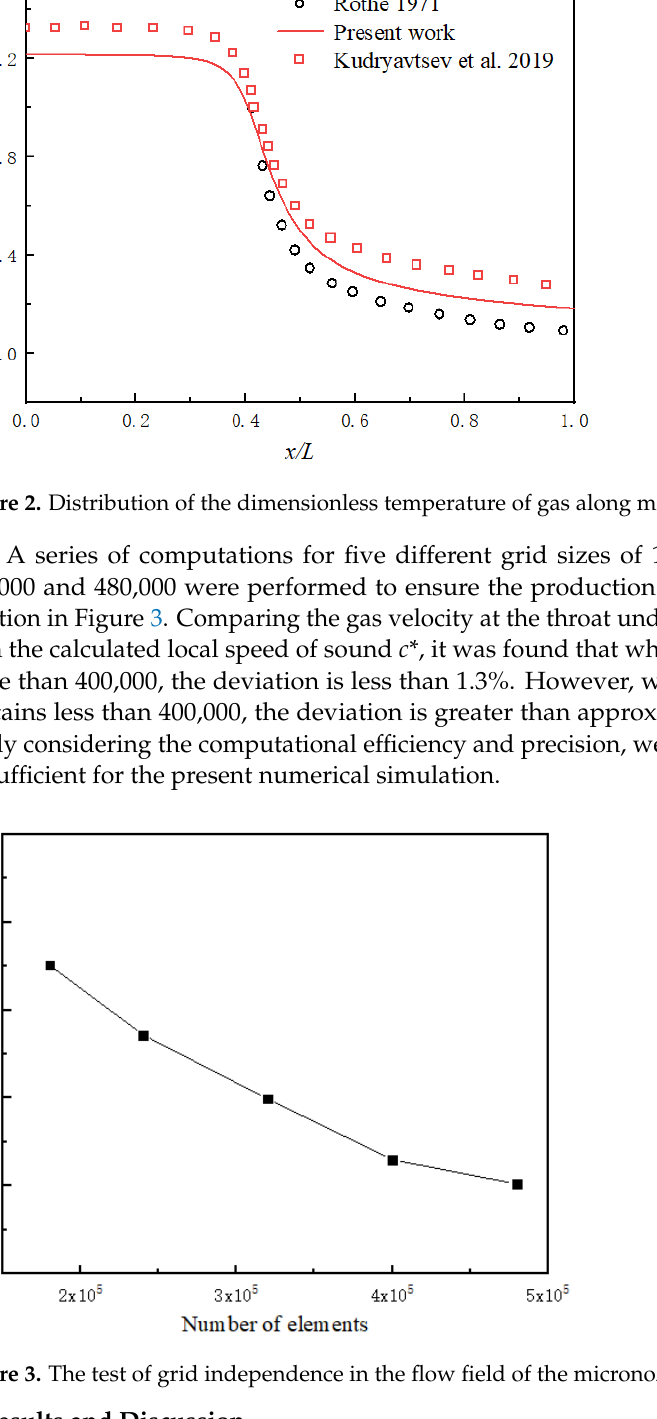
Figure 3. The test of grid independence in the flow field of the micronozzle.